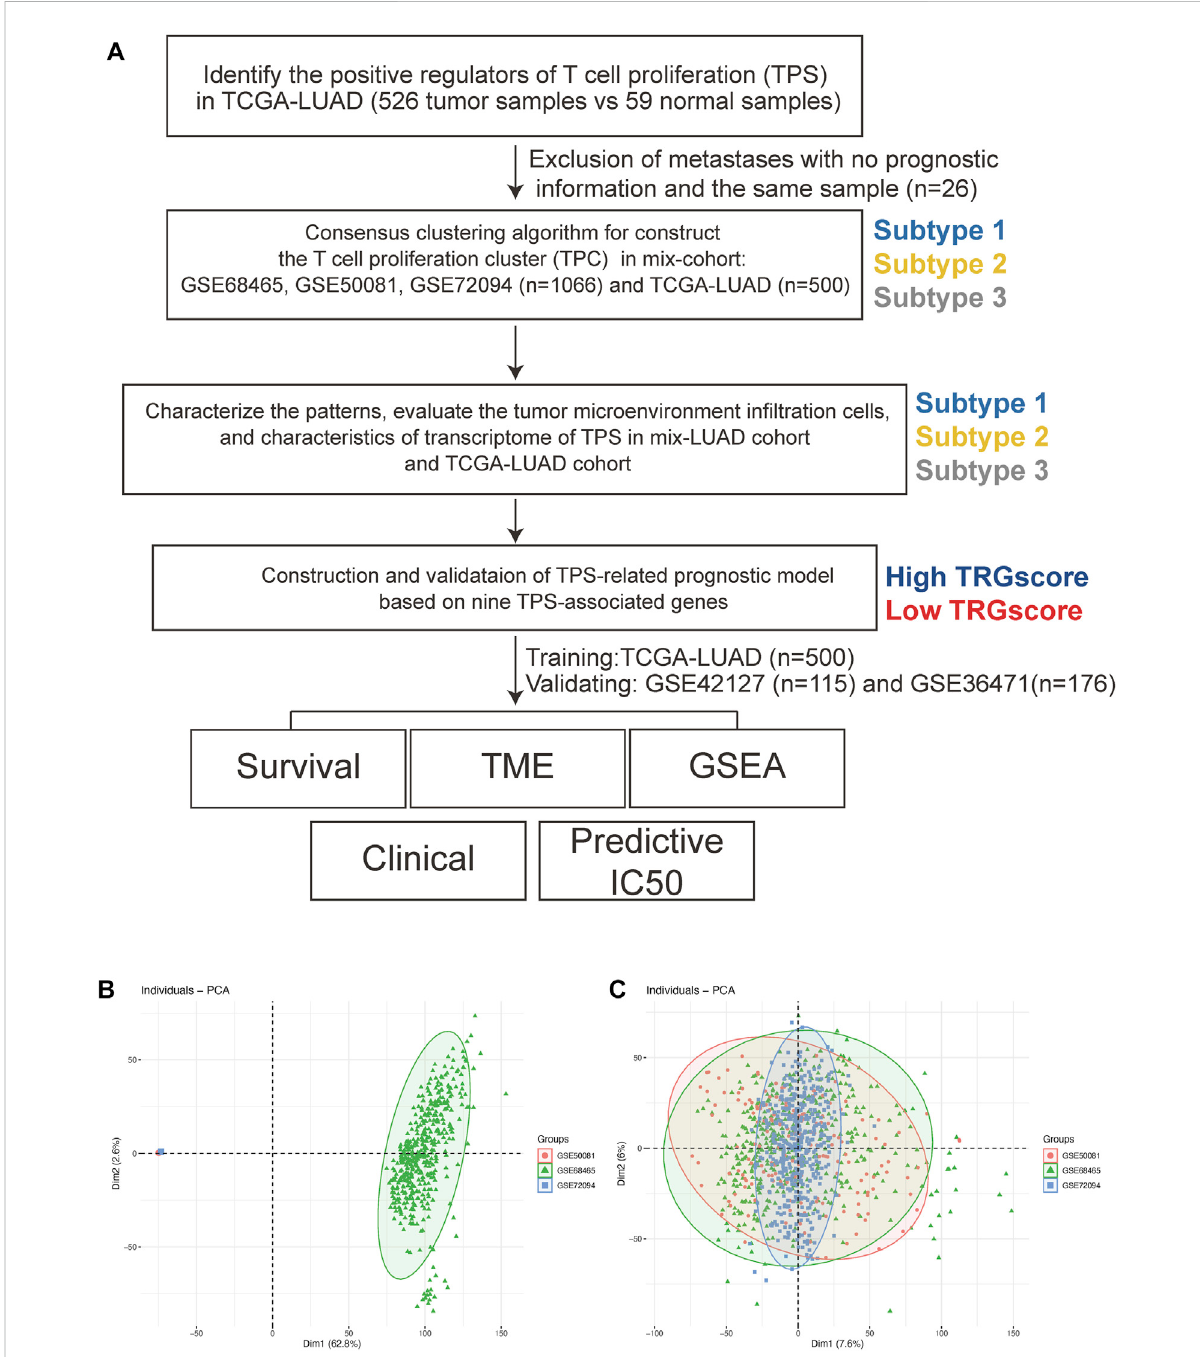
FIGURE 1 The work fl ow of this study. (A) The work fl ow chart of this study. (B,C) Principal component analyses before (B) and after (C) batch